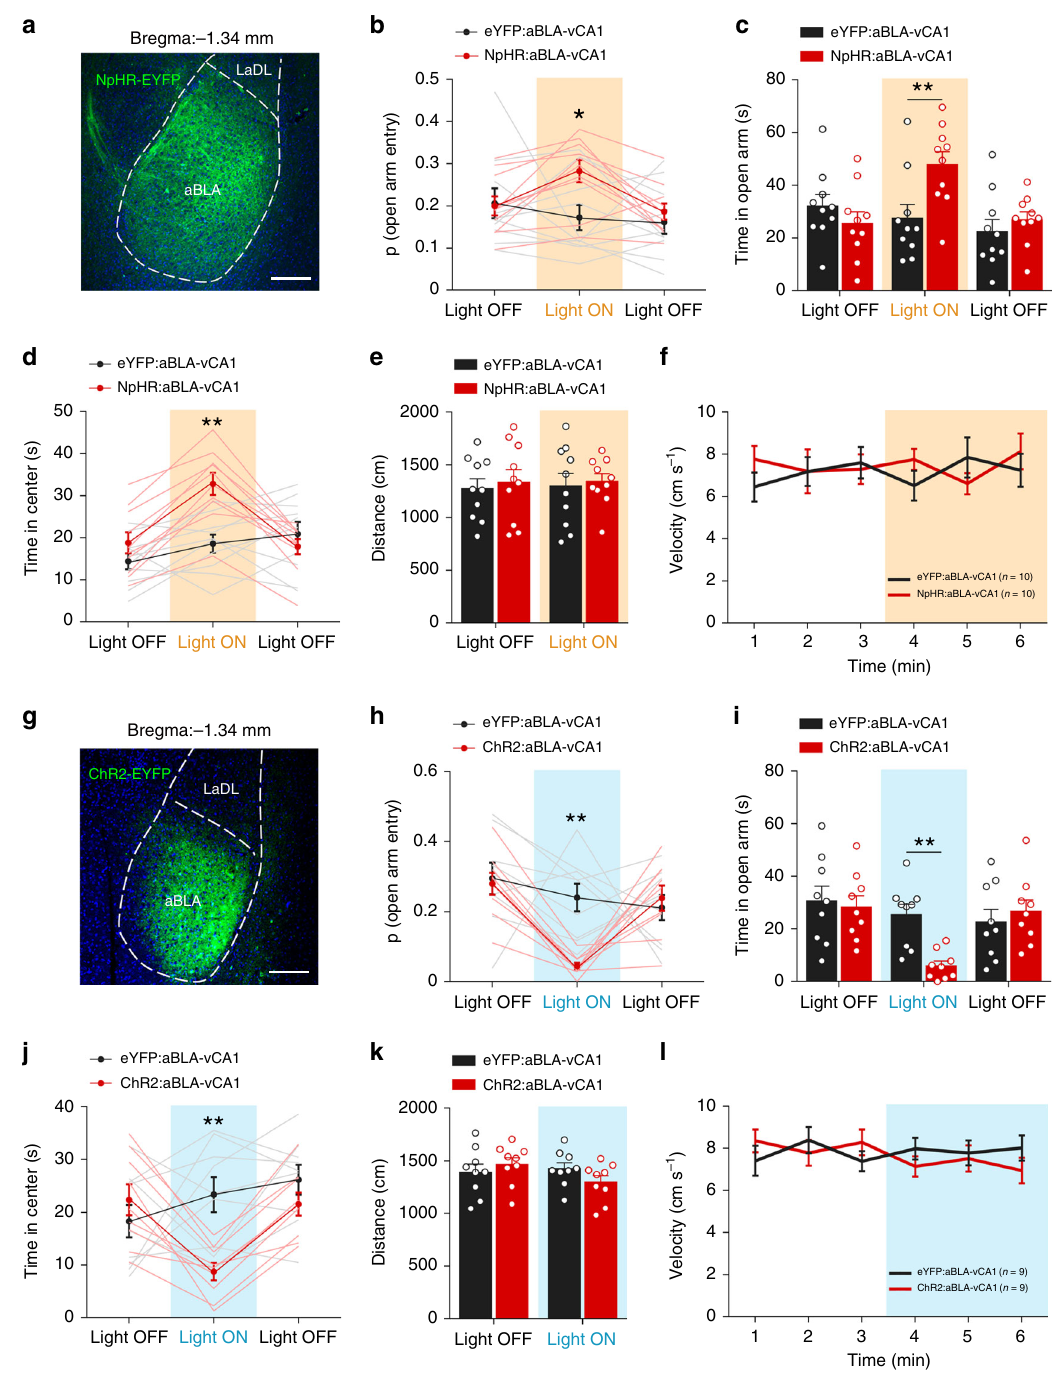
Fig. 3 aBLA – vCA1 inputs promote avoidance behaviour and exert anxiogenic effects. a , g Representative confocal images of ChR2 ( a ) and NpHR ( g ) expression in the aBLA. Scale bar, 200 μ m. ChR2 ( b – d ) and NpHR ( h – j ) mice were tested in the EPM ( b , c , h , i ) and OFT ( d , j ) as described in Fig. 2. During the illumination epoch in the EPM, the probability of open-arm entry and time spent in the open arms decreased in ChR2 mice ( b , c ) but increased in NpHR mice ( h , i ) compared with eYFP mice (two-way ANOVA group × epoch interaction; probability of open-arm entry [ChR2] F (2, 32) = 5.477, P = 0.0090, Bonferroni post hoc analysis, ** P < 0.01; [NpHR] F = 3.409, P = 0.0441, Bonferroni post hoc analysis, * P < 0.05; time spent in open arms (2, 36) [ChR2] F (2, 32) = 4.449, P = 0.0197, Bonferroni post hoc analysis,** P < 0.01; [NpHR] F (2, 36) = 6.815, P = 0.0031, Bonferroni post hoc analysis, ** P < 0.01. During the illumination epoch in the OFT, the time spent in the centre decreased in ChR2 mice ( d ) but increased in NpHR mice ( j ) (two - way ANOVA group × epoch interaction, ChR2: F (2, 32) = 9.428, P = 0.0006, Bonferroni post hoc analysis, ** P < 0.01; NpHR: F (2, 36) = 14.27, P < 0.0001, Bonferroni post hoc analysis, ** P < 0.01). No effects of light stimulation on distance travelled ( e , k ) or velocity ( f , l ) were detected. Two - way ANOVA group × epoch interaction, travelled distance [ChR2] F (1, 16) = 2.312, P = 0.1479; [NpHR] F (1, 18) = 0.007063, P = 0.9340; velocity [ChR2] F (5, 80) = 1.13, P = 0.3514; [NpHR] F (5, 90) = 1.188, P = 0.3212. n = 10 mice ( b – f ) or 9 mice ( h – l ) per group. Data are presented as the mean ± SEM. Source data are provided as a Source Data fi